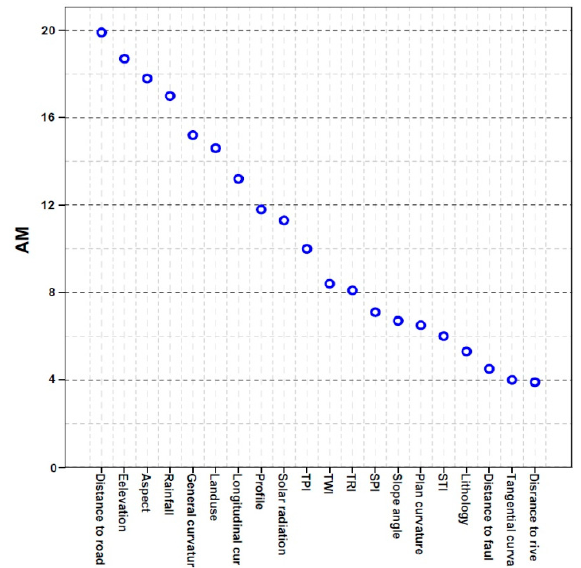
Figure 4. Factor selection using least square support vector machine (LSSM).